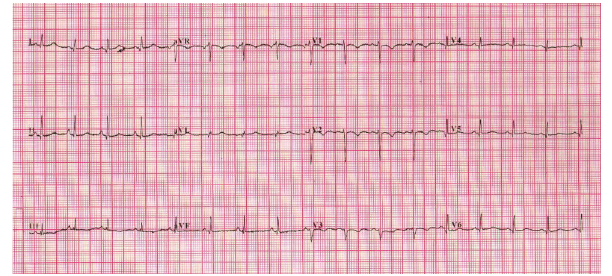
Figure 5: Electrocardiogram obtained 4 months after the acute coronary syndrome. It shows normalization of R wave progression.